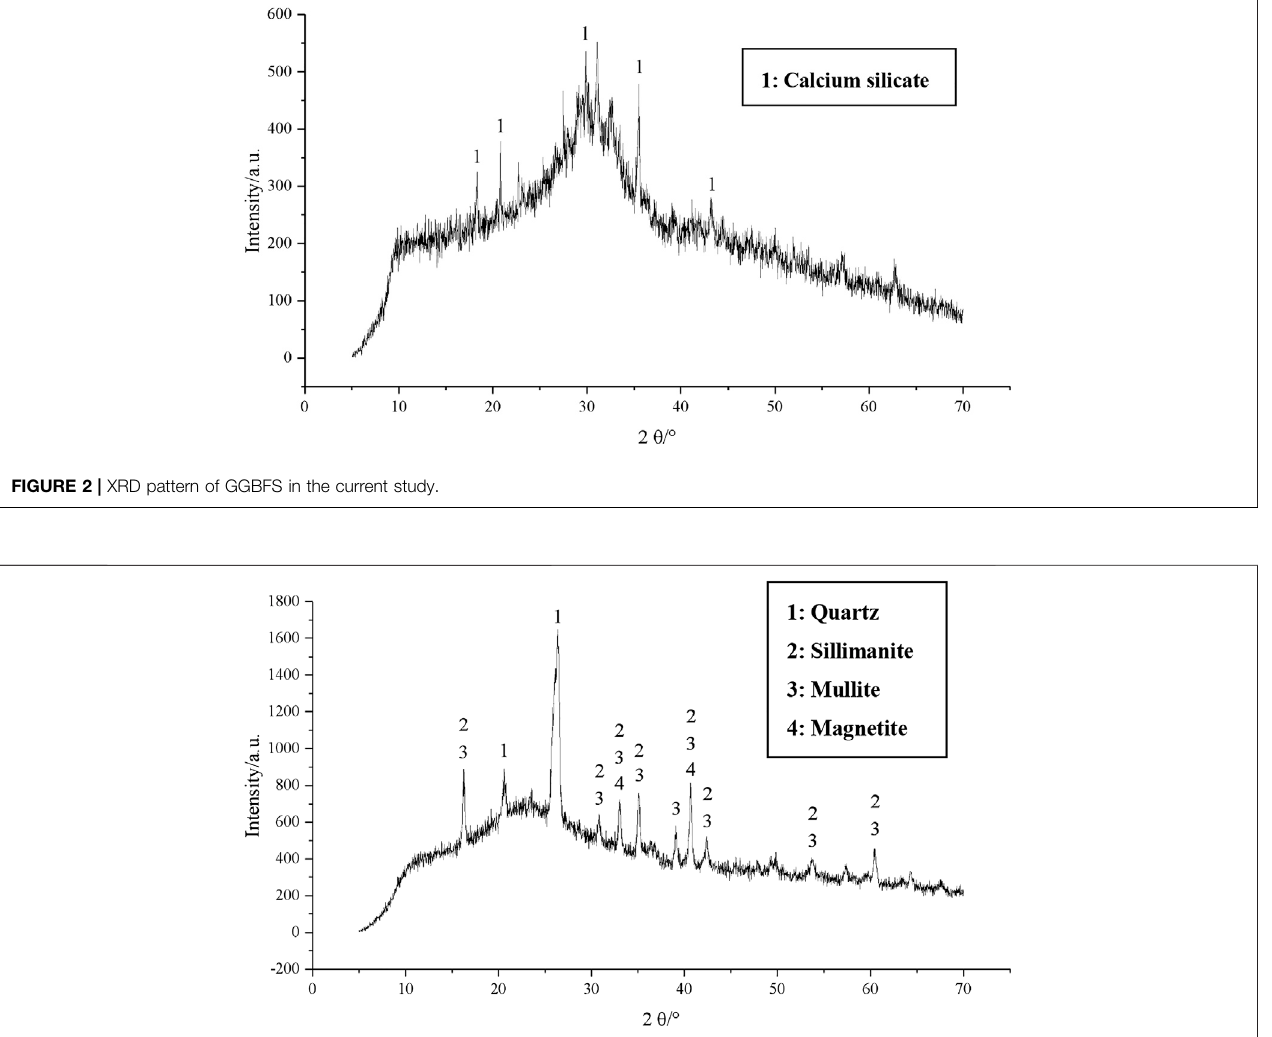
FIGURE 3 | XRD pattern of FA in the current